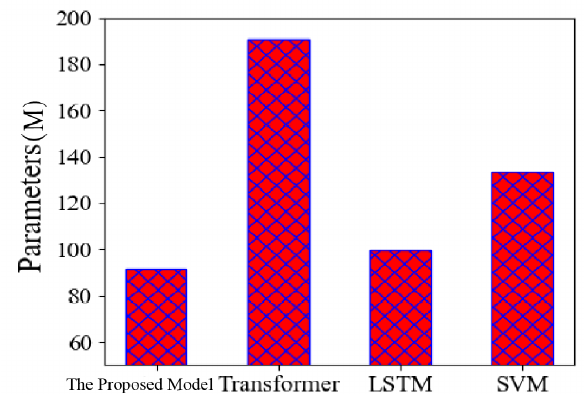
Figure 9. Comparison of the parametric quantities of models.